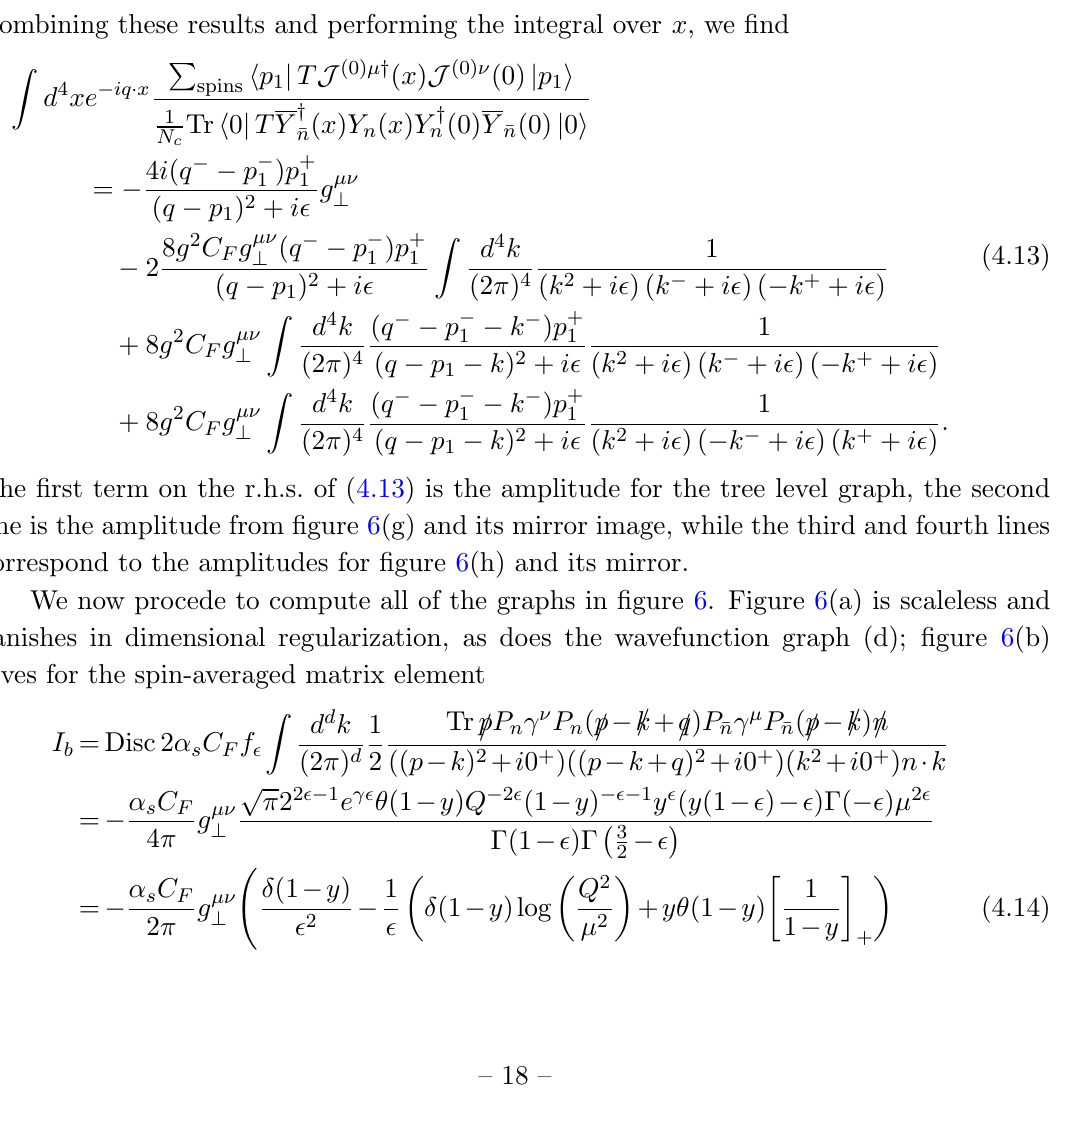
Figure 6 . One loop corrections to the product of two electromagnetic currents in SCET. Figures (g) and (h) are the overlap subtractions. The angle of the Wilson line indicates whether it is in the n or (cid:22) n